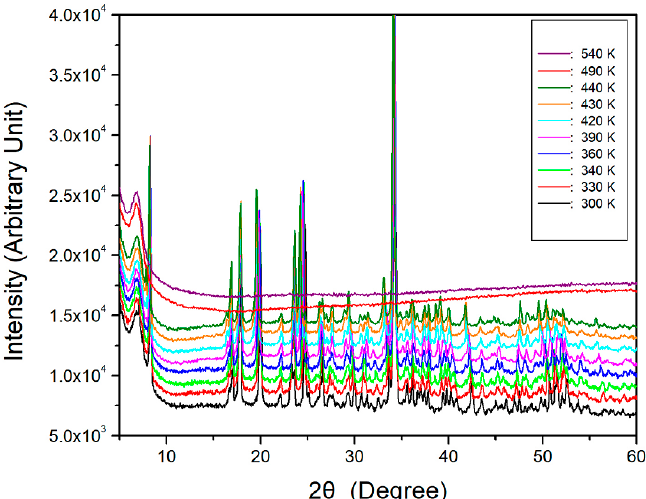
Figure 1. XRD powder patterns of the [NH 3 (CH 2 ) 5 NH 3 ]CuCl 4 crystal at different temperatures.